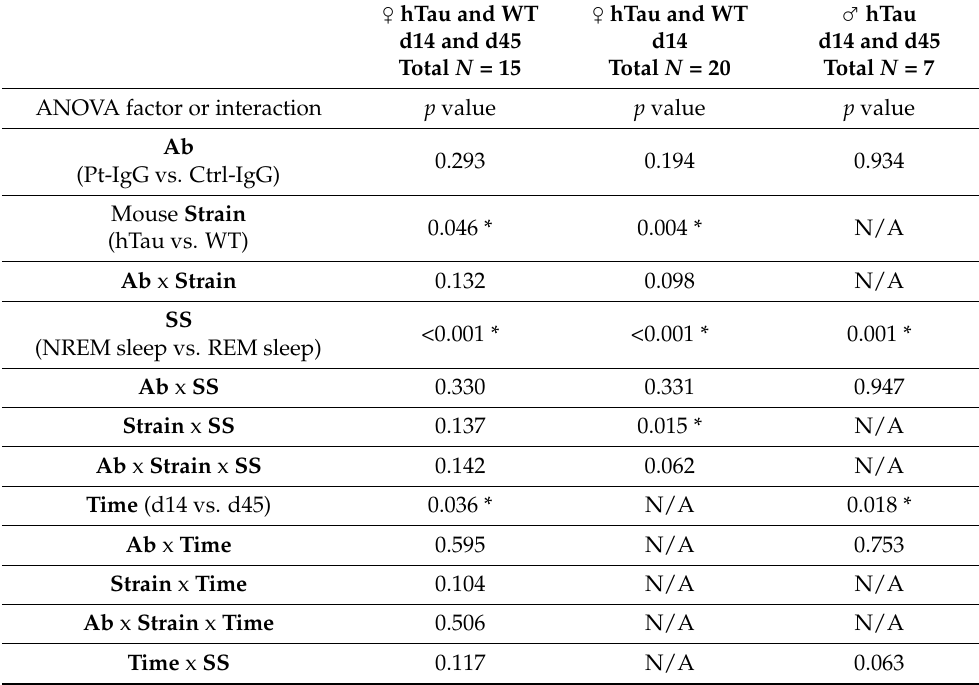
Table A7. Statistical analysis of EEG power theta/delta ratio during